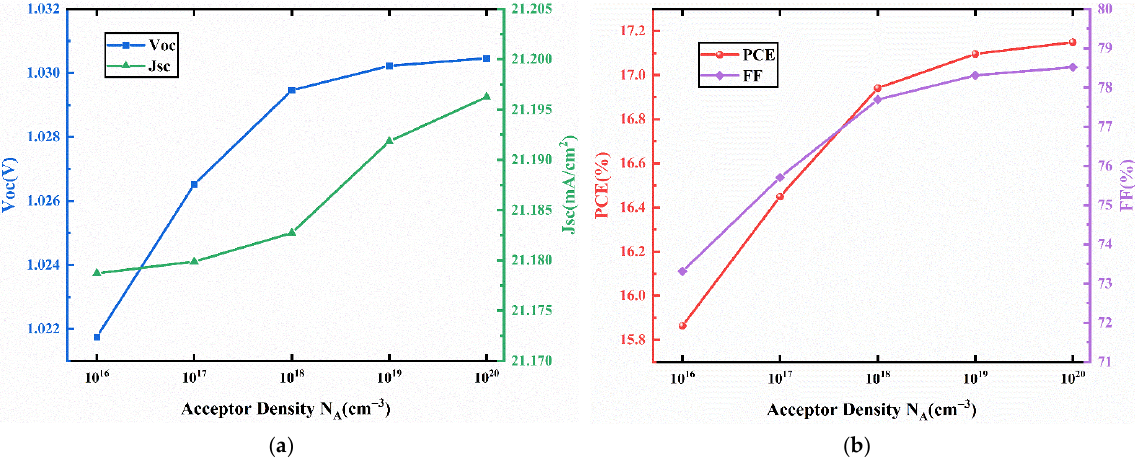
Figure 8. ( a ) Change in Voc and Jsc against acceptor density (N A ) variation; ( b ) change in PCE and FF against HTL doping density (N A ) variation.